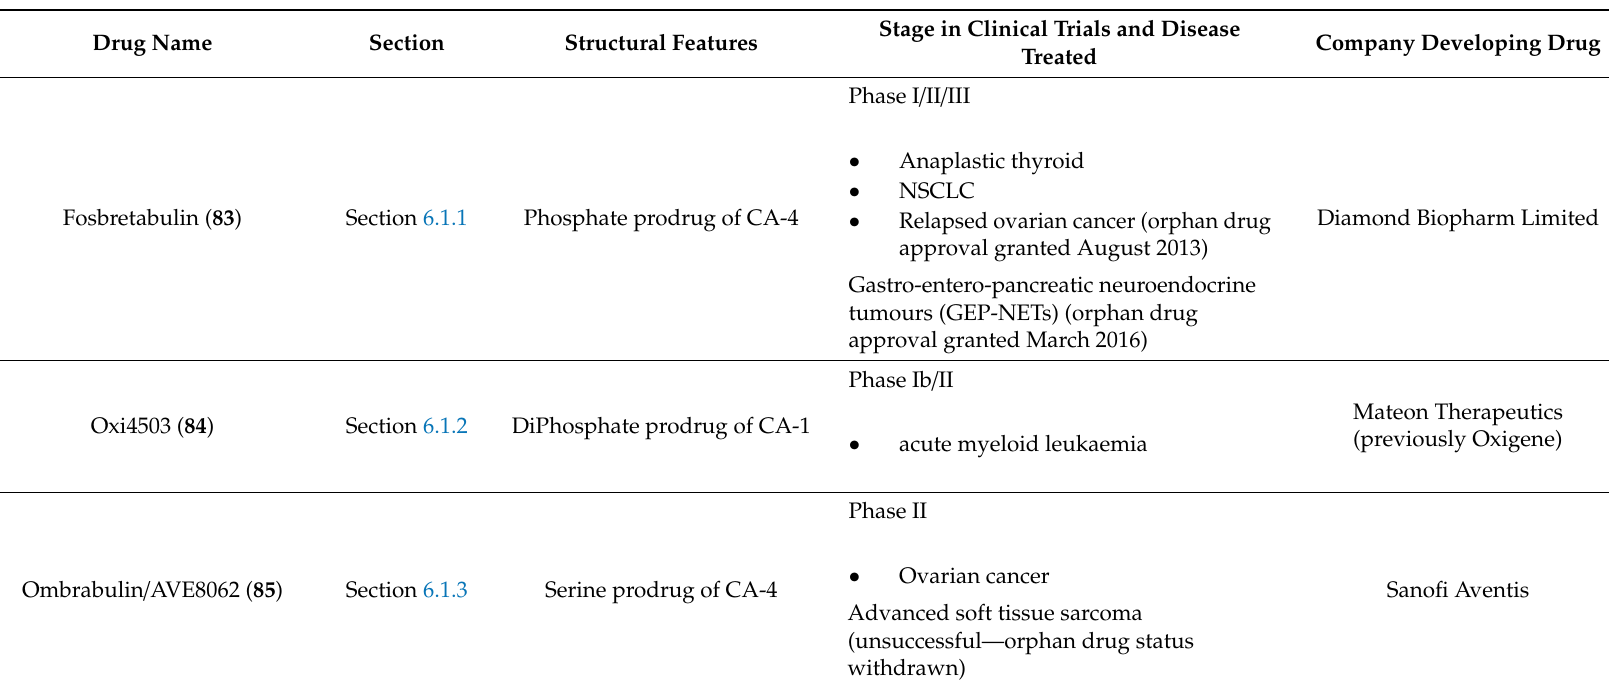
Table 2. Summary of colchicine-binding site inhibitors (CBSIs) in clinical trials and clinical use—combretastatin A-4